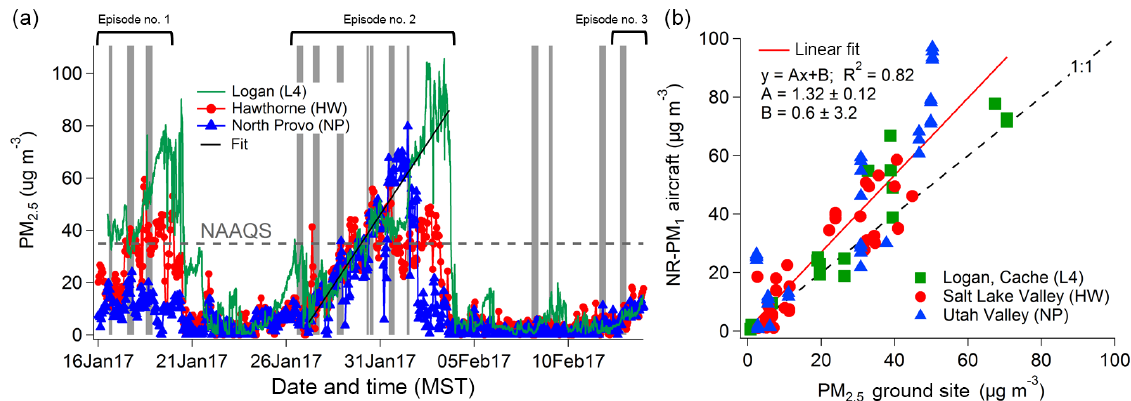
Figure 2. PM 2 . 5 measurements from three ground sites during UWFPS. (a) Time series of PM 2 . 5 measured in Logan (L4), Cache Valley, in green; at Hawthorne Elementary School (HW), Salt Lake Valley, in red; and in North Provo (NP), Utah Valley, in blue. The grey shaded areas correspond to the times of Twin Otter flights; the horizontal dashed line indicates the National Ambient Air Quality Standard (NAAQS) of 35µgm − 3 for 24h averaged PM 2 . 5 . The black solid line is a fit over all the data of the increase in PM 2 . 5 during Episode 2. The slope is 10 . 89 ± 0 . 08µgm − 3 day − 1 (slope ± 95% CI). (b) Comparison of the non-refractory (NR) PM 1 measured with the AMS from the Twin Otter for altitudes lower than 50ma.g.l. during the missed approaches at the airports closest to the ground site measurements. The dashed line is the 1 : 1 line and the red solid line is a linear fit; correlation coefficient, fit coefficients, and their 95% CI are reported in the